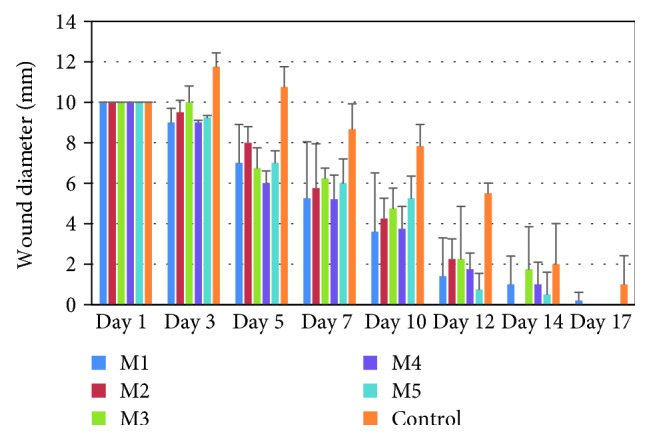
Wound diameter (mm) evolution after treatment with spongious matrices loaded with FA in experimentally induced burn to Wistar rats (bars in the graph represent standard deviation).